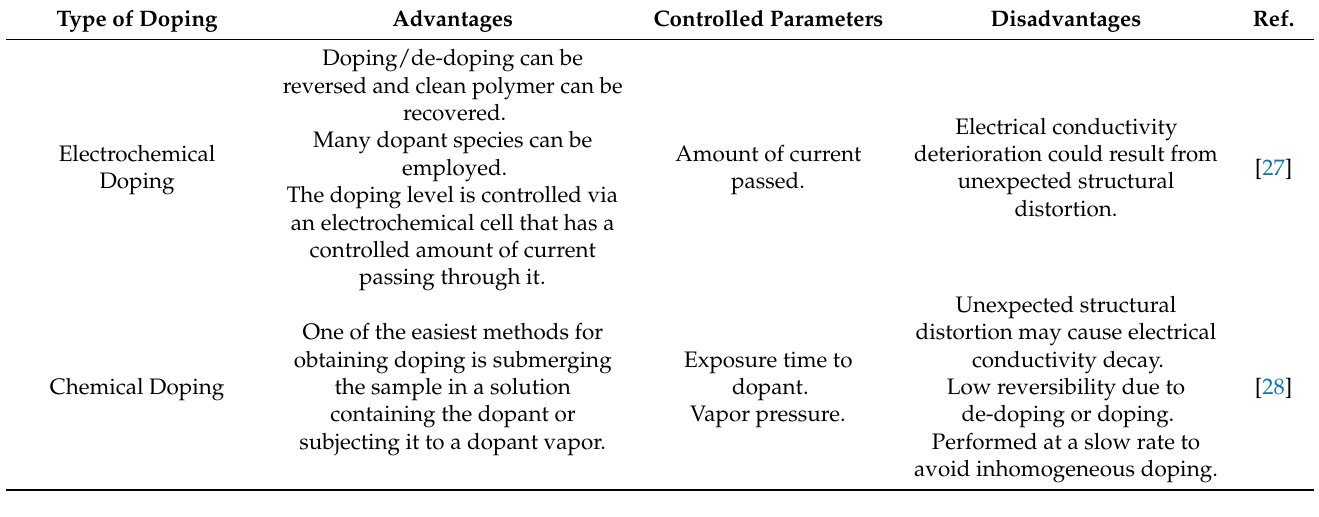
Table 1. A brief overview of the doping methodology.